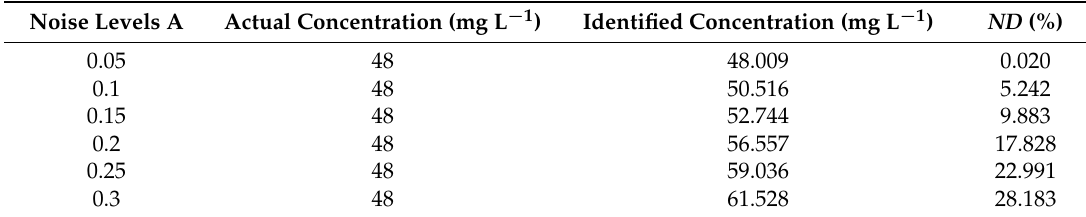
Table 5. Identified results with different noise levels.